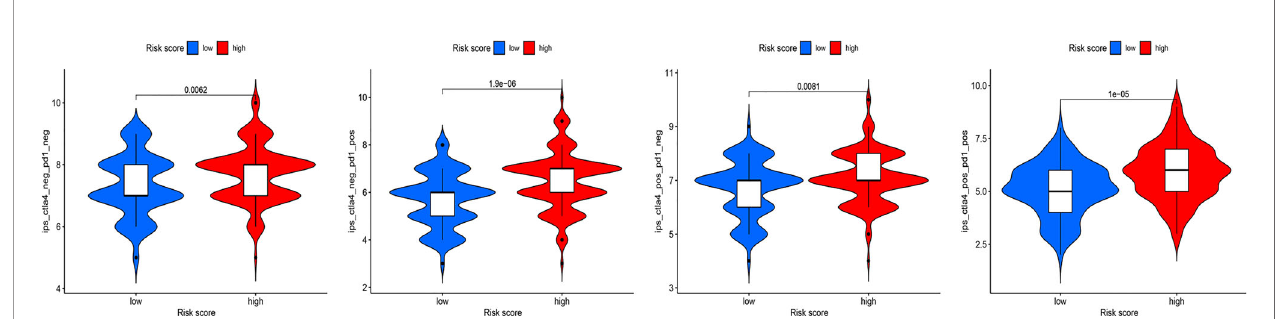
FIGURE 11 | The association between IPS and risk groups of OC patients.